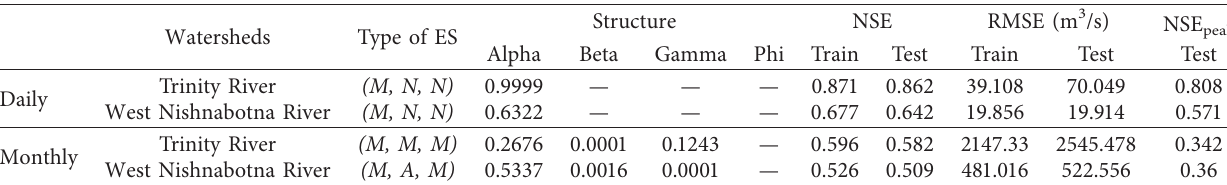
Table 5: Performance results of the ES method.